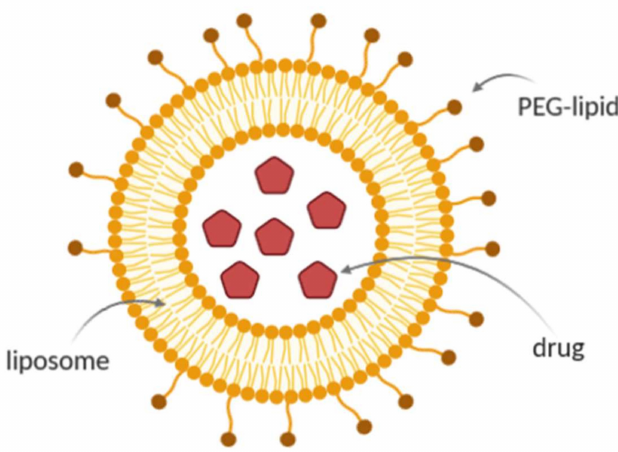
Figure 4. Structure of a liposome with polyethylene glycol